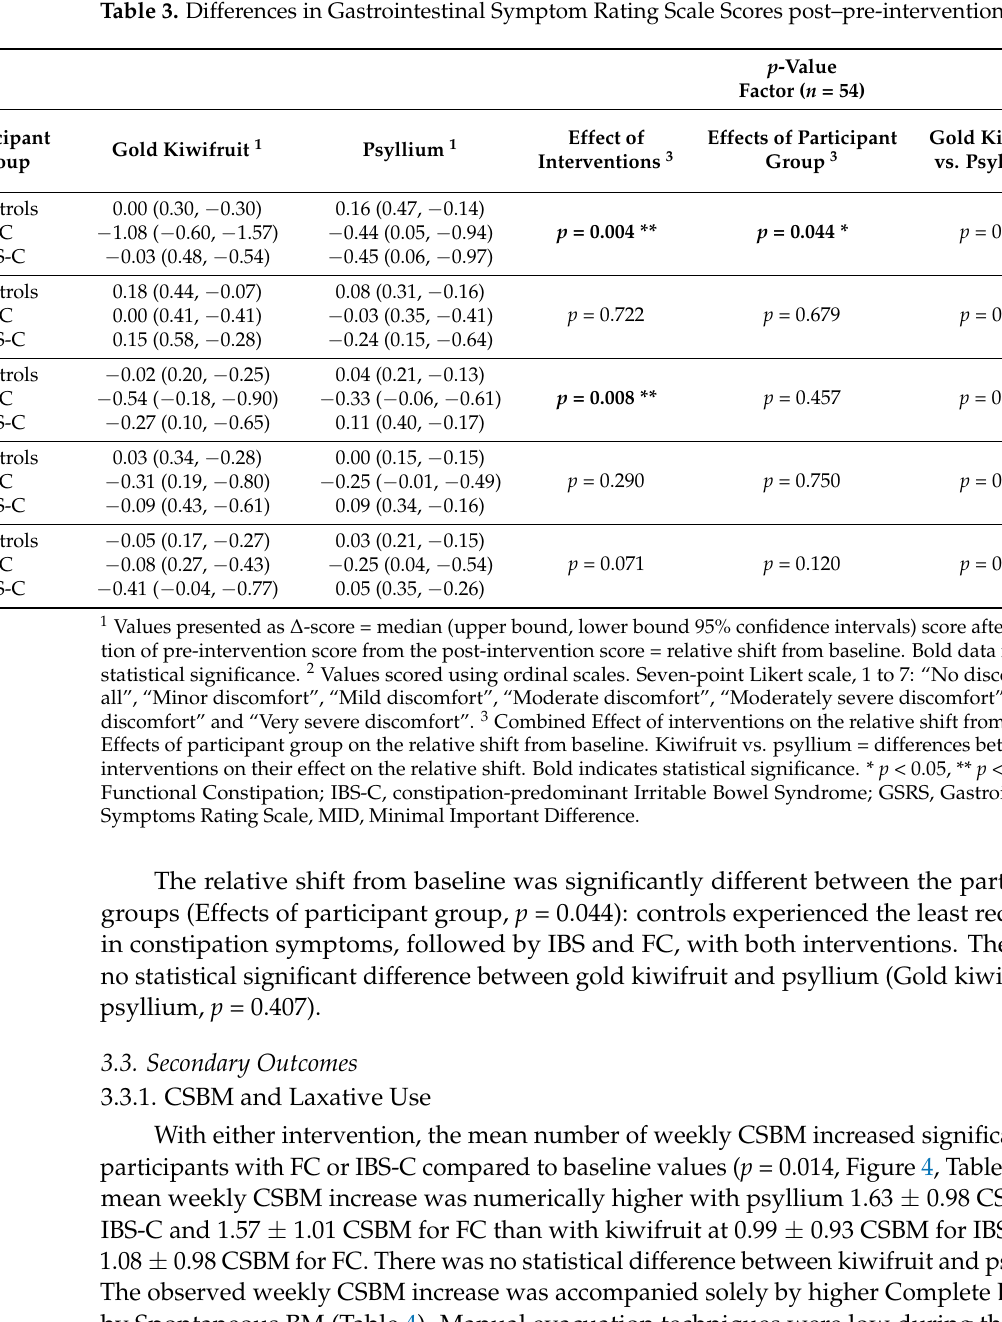
Table 3. Differences in Gastrointestinal Symptom Rating Scale Scores